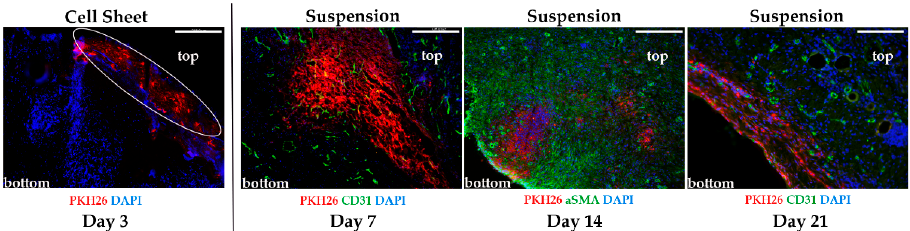
Figure 3. Retention of mesenchymal stromal cells (MSC) labeled by PKH26 after transplantation to pressure ulcers. Cell sheet (CS) is detected on wound surface only at Day 3; PKH26 signal from injected MSC is detectable in the tissue up to Day 21; “top” marks location of wound bed, “bottom” marks deeper layers of skin. Immunofluorescence, scale bar represents 250 µm.